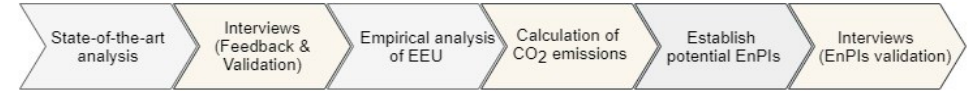
Figure 3. Outline of the methodology used for developing taxonomy and EnPI.